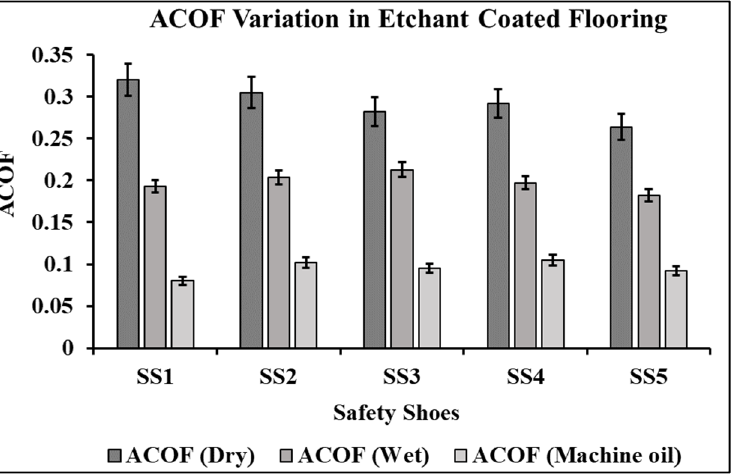
Figure 5. ACOF variation in etchant-coated flooring across dry, wet, and machine oil slip